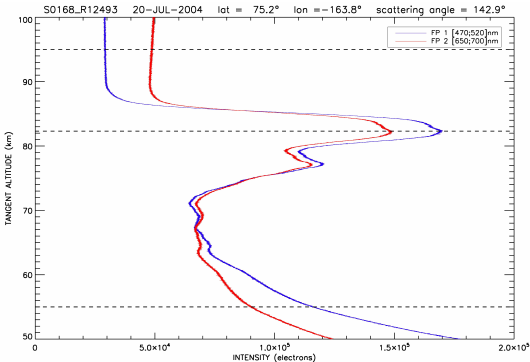
Fig. 45. Example of GOMOS photometers’ observation of a noctilucent cloud (or Polar Mesospheric Cloud), detected as an increase of solar light scattered by the particles of the clouds, in addition to the Rayleigh scattering by air molecules around 85km. The dashed lines indicate, from top, the region with no cloud (signal from the star), the peak intensity of the cloud and the region below the cloud, where the Rayleigh scattering dominates the bright limb intensity (from P´erot et al.,